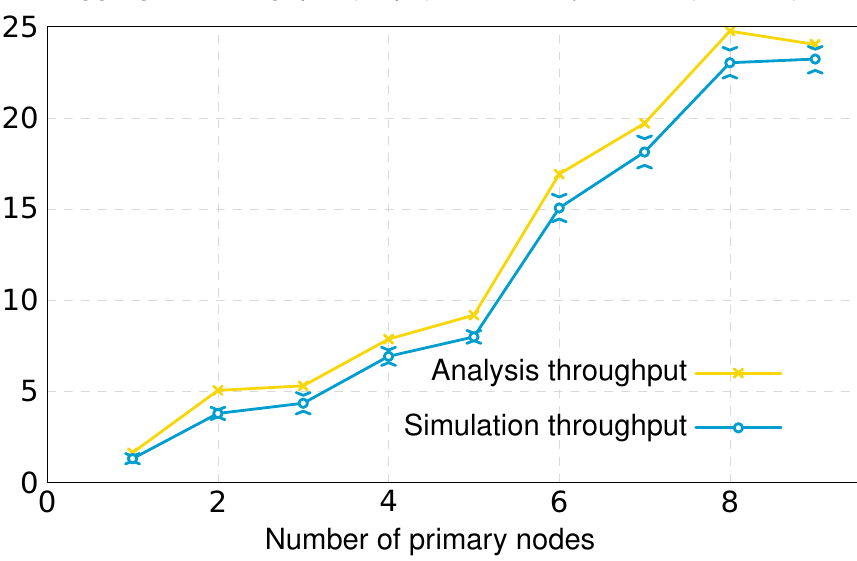
Aggregate throughput for primary nodes. The simulation results show the average aggregate throughput and its standard deviation obtained from 20 simulations with different seeds (95% confidence intervals, Batch Mean Method). Aggregate throughput (Kbps) for Primary Nodes ( N =